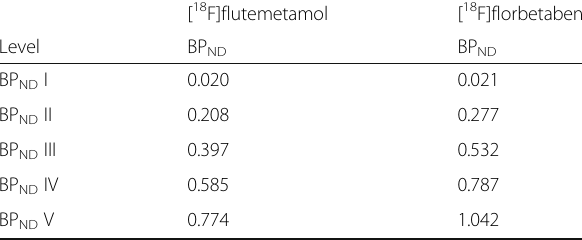
Table 2 Pharmacokinetic parameters for simulating TACs using